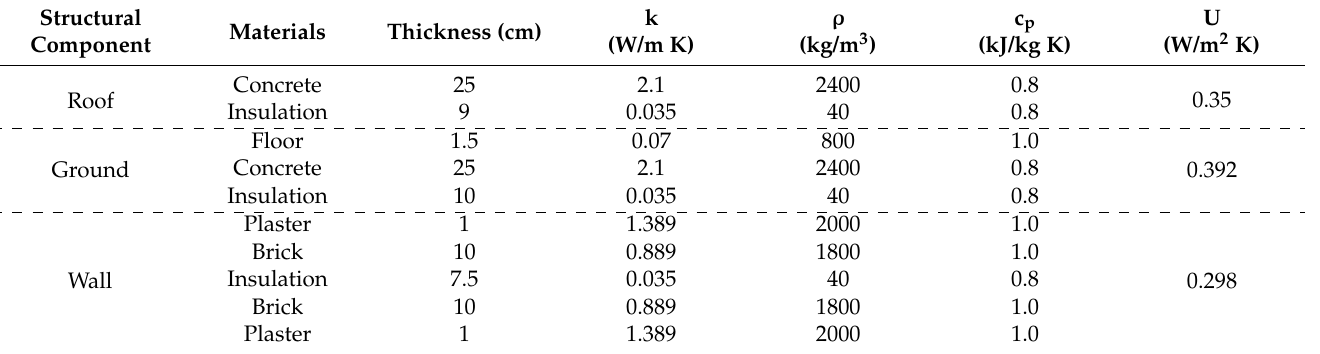
Table 2. Structural elements for the building in Thessaloniki (Zone C).